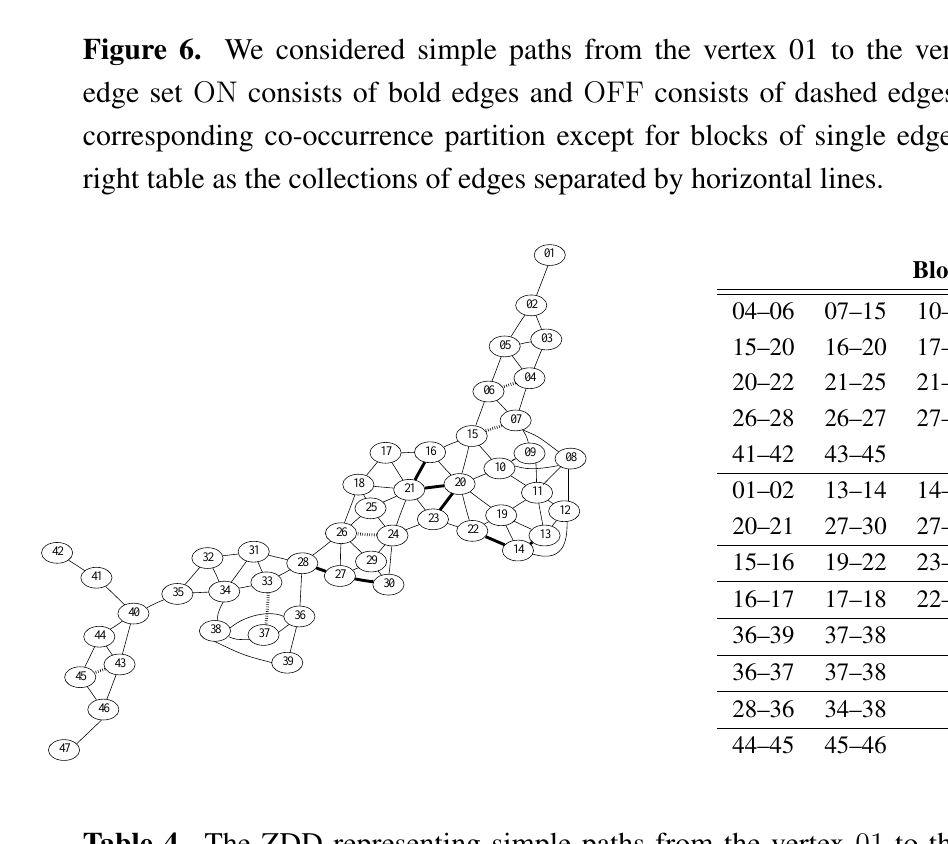
Table 4. The ZDD representing simple paths from the vertex 01 to the vertex 47 , where n; k; m denote the parameters given in Theorem